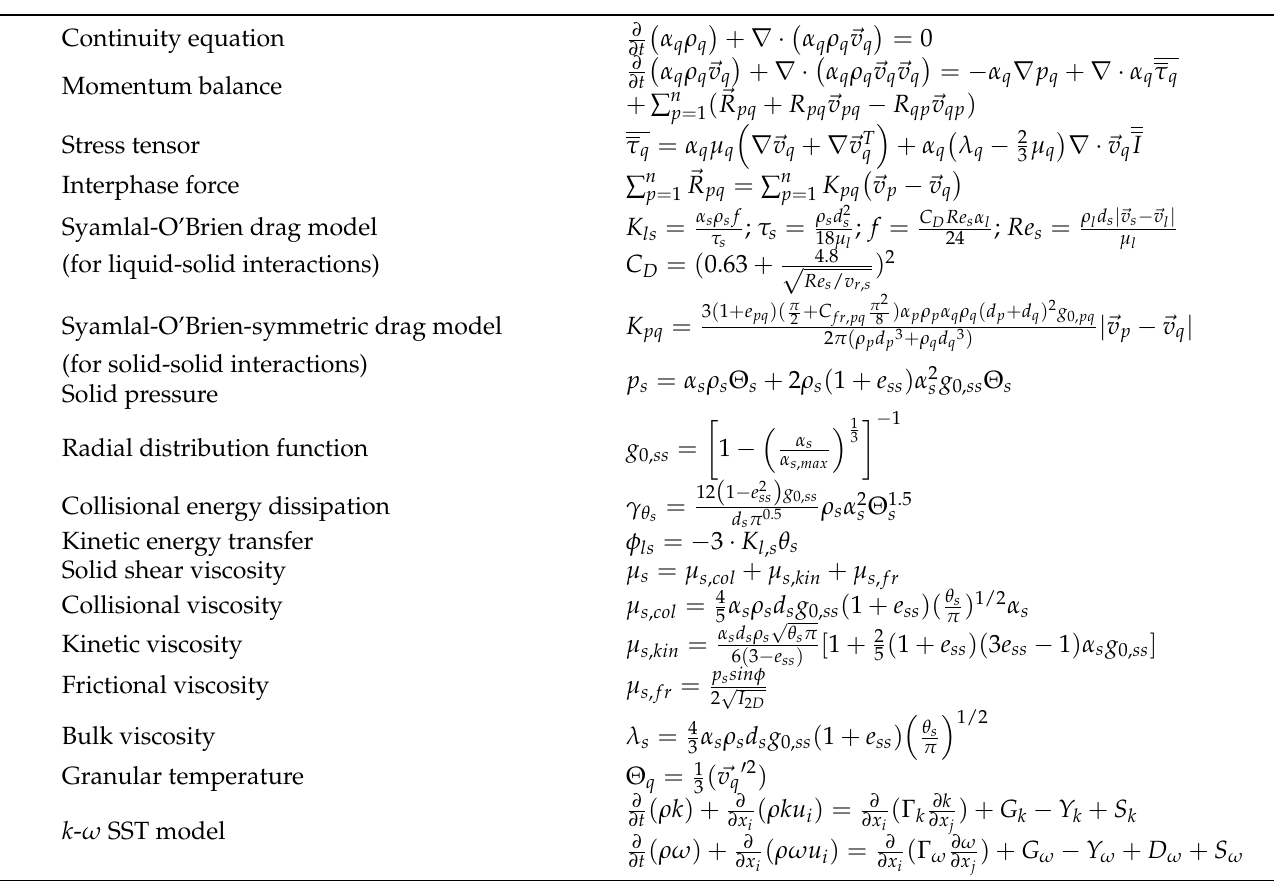
Table 2. Governing equations used in the simulations.